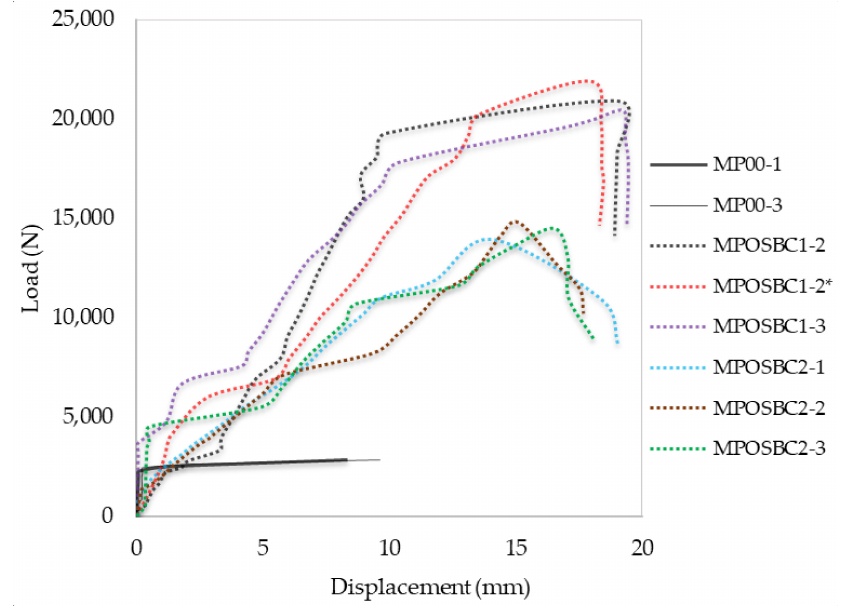
Figure 6. Load displacement curves for MP specimens. MPOSBC1-2* was constructed to replace the damaged